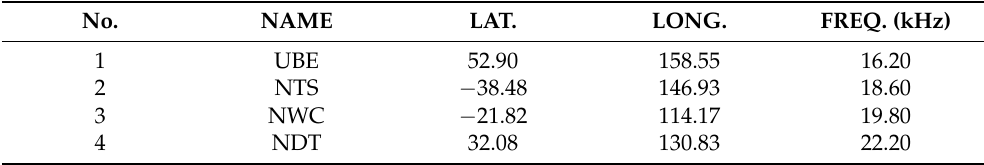
Figure 7. The average VLF power spectral density during the nighttime and daytime in the Asian sector(70 ◦ E– 160 ◦ E) when NWC is ( a ) ON (from July 2006 to January 2007) and ( b ) OFF (from July 2007 to January 2008). The geolocations of four artificial VLF transmitters (i.e., UBE, NTS, NWC and NDT) marked with magenta solid triangles. The black solid curves indicate the L = 1.4 contours at the satellite altitude and the black dashed ones show the magnetic equator. The red stars indicate the epicenter of the Jakarta–Java earthquake. The red dashed circles indicate the estimated earthquake preparation zone. Table 1. The information of four VLF transmitters in the Asian